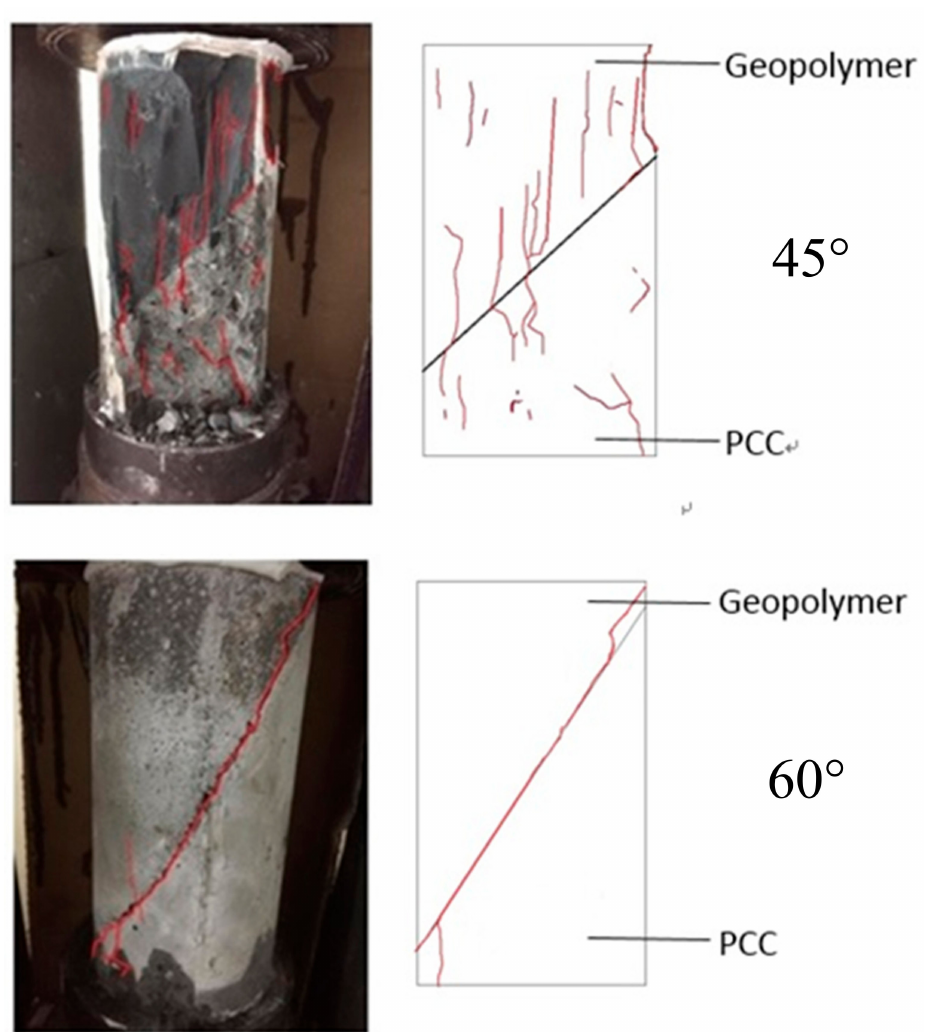
Figure 7. FGG repair angle when the damage pattern is di ff erent. ( a ) 45-degree angle cracked; ( b ) 60-degree angle sliding